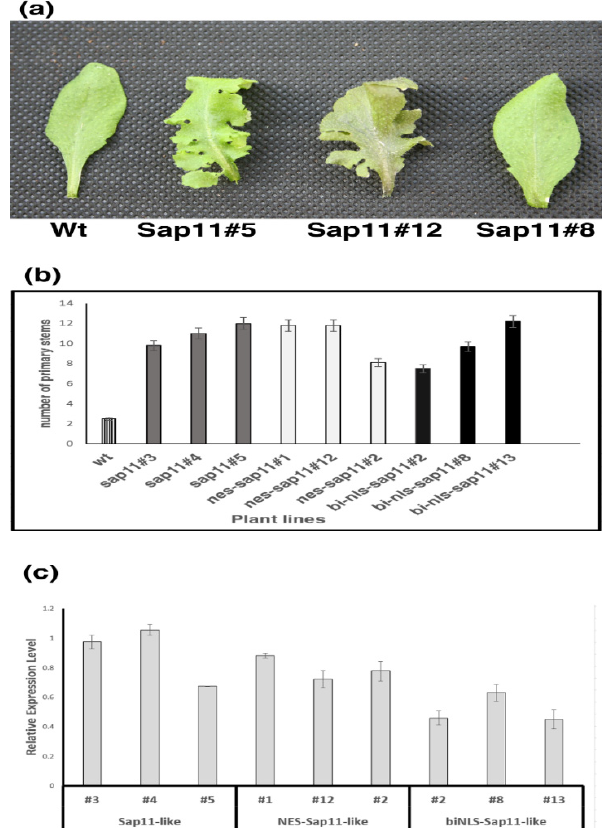
Figure 2. Transgenic plants expressing wt SAP11 PM19 and its derivatives. Transgenic A. thaliana lines expressing SAP11 PM19 (Sap11), NES-SAP11 PM19 (NES-Sap11) and bi-NLS-SAP11 PM19 (NLS-Sap11) under the control of the Cauliflower mosaic virus 35S promoter compared to wt Arabidopsis Col-0 plant. All plants were grown for 8 weeks in long-day (16 h/8 h light/dark) conditions. For each of the three constructs, at least 3 lines were examined, all showing similar phenotypic characteristics. ( a ) Leaf morphology of transgenic and wt plant lines. ( b ) Number of shoots developed by transgenic A. thaliana lines compared to the wt Col-0 plant. ( c ) Relative expression levels of transgenes of trans- genic lines compared to the geometric average of glyceraldehyde-3-phosphate dehydrogenase ( GAPDH ) and protein phosphatase 2 ( PP2A ). All values show a p -value lower than 0.05 in